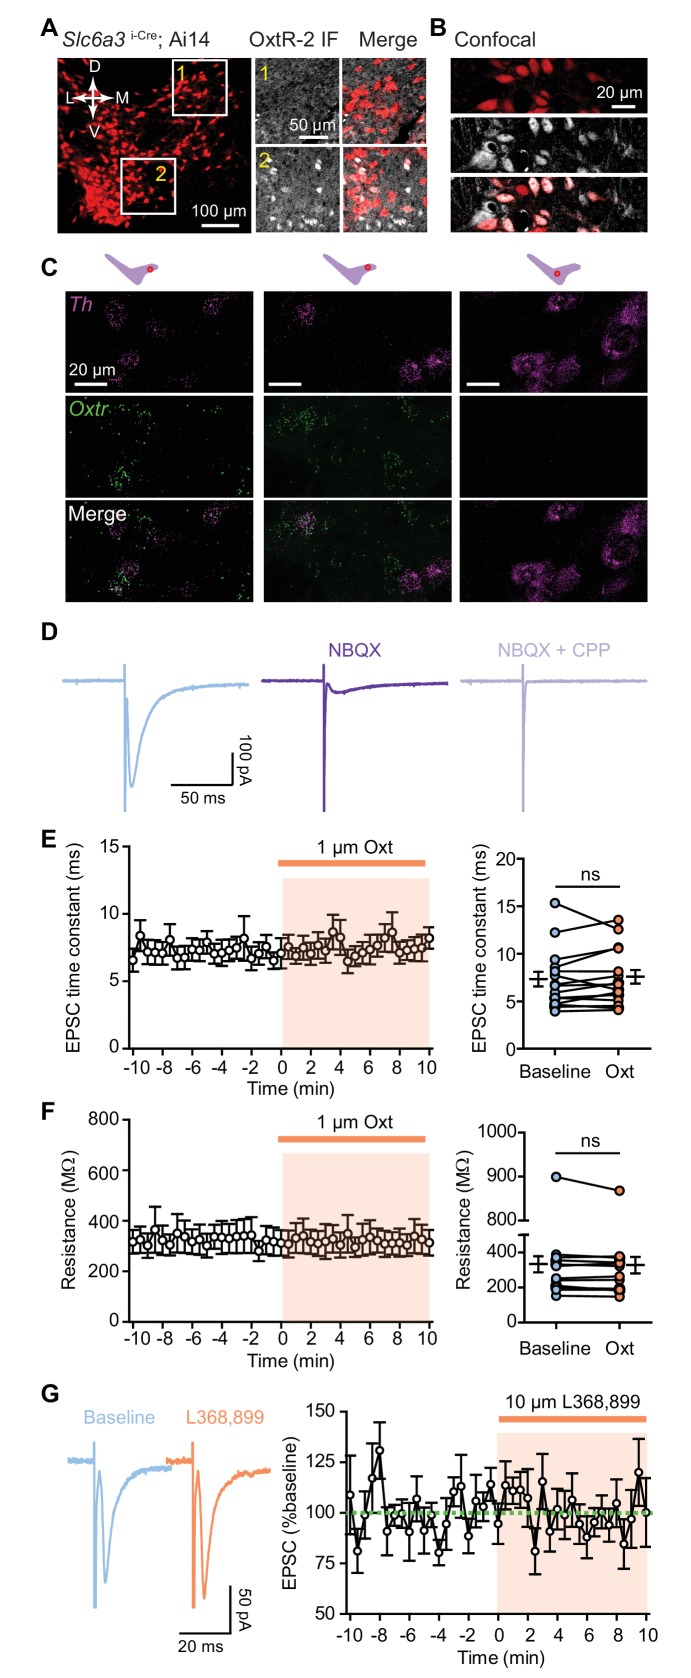
Characterization of targeted VTA subregions and physiological properties of recorded VTA DA neurons.(A) Immunostaining with OxtR-2 antibody illustrates OxtR expression patterns in the VTA of Slc6a3i-Cre; Ai14 mice. Left: an image of a coronal brain section of VTA from a Slc6a3i-Cre; A14 mouse. Right: OxtR expression in different subregions of VTA, as indicated. (B) Confocal image highlights partial overlap between tdTomato-positive and OxtR-positive neurons in ventromedial VTA. (C) Fluorescence in situ hybridization (FISH) images in different subregions (indicated on top) of the VTA. Th (magenta) and Oxtr (green). (D) Example evoked EPSC traces from one VTA DA neuron in the baseline condition and following sequential application of AMPAR antagonist NBQX (10 µM) and NMDAR antagonist CPP (10 µM). Evoked EPSCs recorded at −70 mV are primarily driven by AMPA receptors, with a minor contribution of NMDARs. (E–F) Summary data showing that EPSC decay time constant and membrane resistance in VTA DA neurons are not altered by oxytocin application. p=0.303 or 0.266 respectively, Wilcoxon matched-pairs signed rank test, n = 15 neurons from 10 mice. (G) Left: example traces from one neuron before and during OxtR antagonist L368,899 application. Right: summary data for n = 6 neurons from three mice. Error bars reflect SEM.